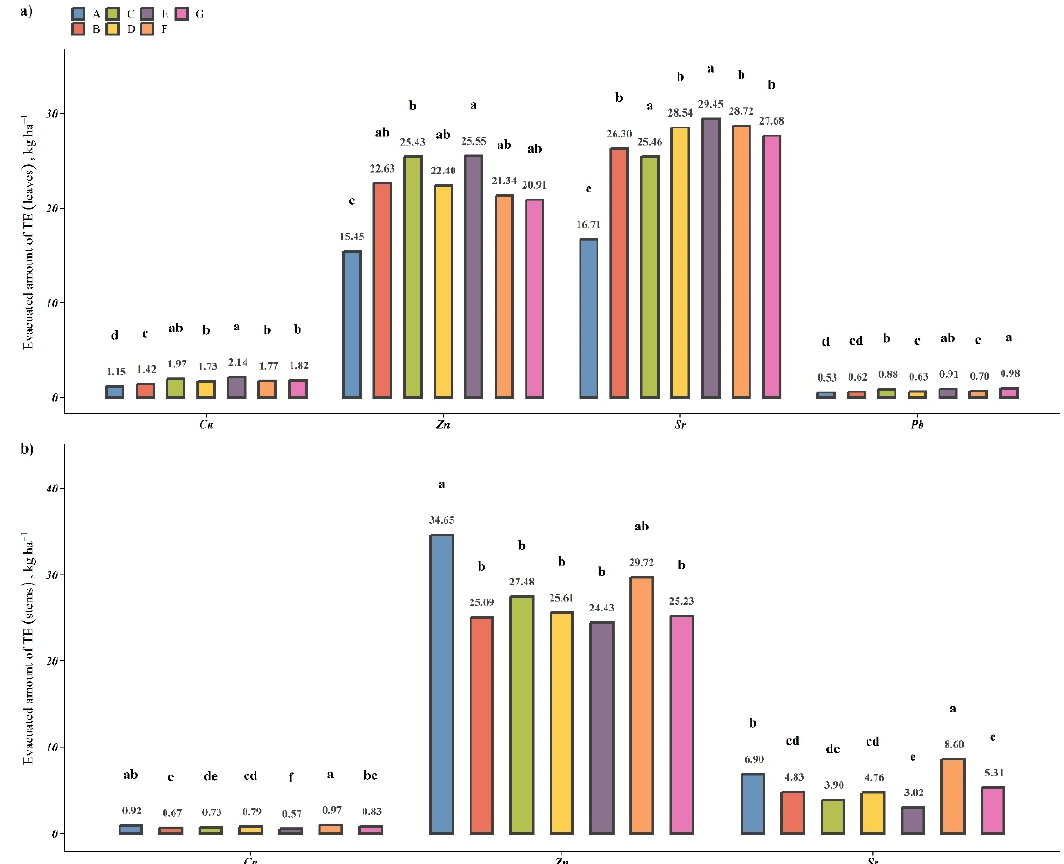
Figure 5. The quantity of TEs potentially extracted by M. × giganteus from 1 ha in 1 year of cultivation for ( a ) leaves and ( b ) stems. Different letters within one TE indicate a significant difference between treatments.